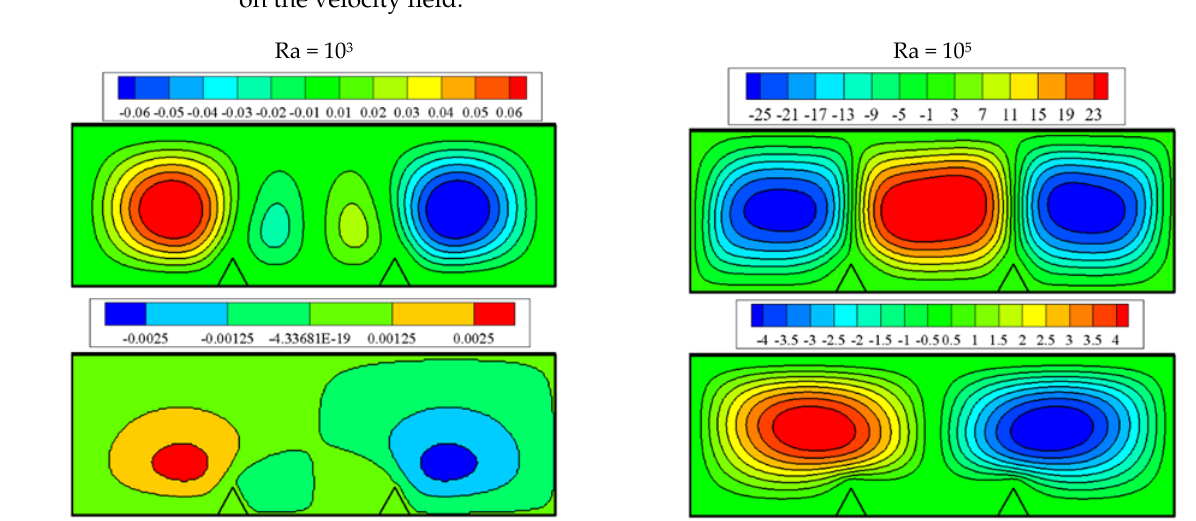
Figure 3. The effect of Ra and Ha on the velocity field for H = W = 0.2. Figure 4 reveals the effect of Ra and Ha on the temperature field for H = W = 0.2 and a volume fraction of 0.3%. In the case of low Ra, the isotherms do not change with the Ha and remain as parallel lines. However, for Ra = 10 5 , the variations of the Ha affect the isotherms and change their shape. The changes of the Ra also affect the temperature contours, changing it from parallel lines to overlapping ones.